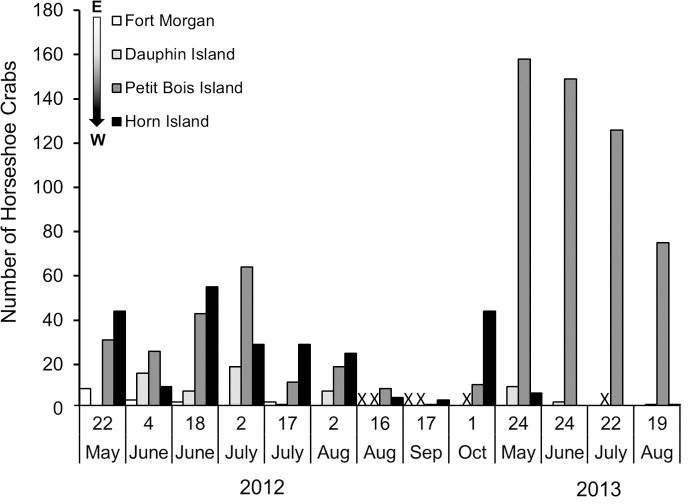
Number of horseshoe crabs (live, molts, carcasses) found at each site on each survey during the 2012 to 2013 survey period.The arrow notes the progression from east to west away from the Mobile Bay discharge. No bar indicates 0 horseshoe crabs found, and X indicates no survey.